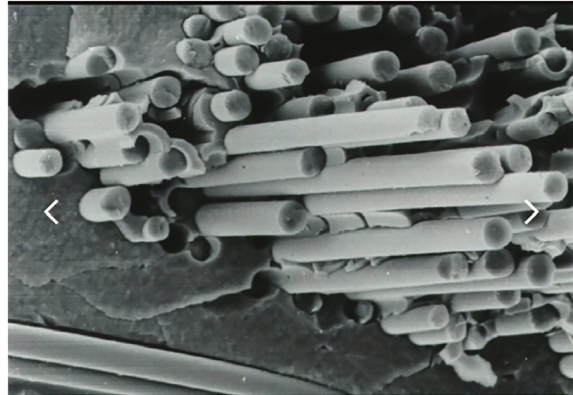
Figure 2: Ceramic matrix